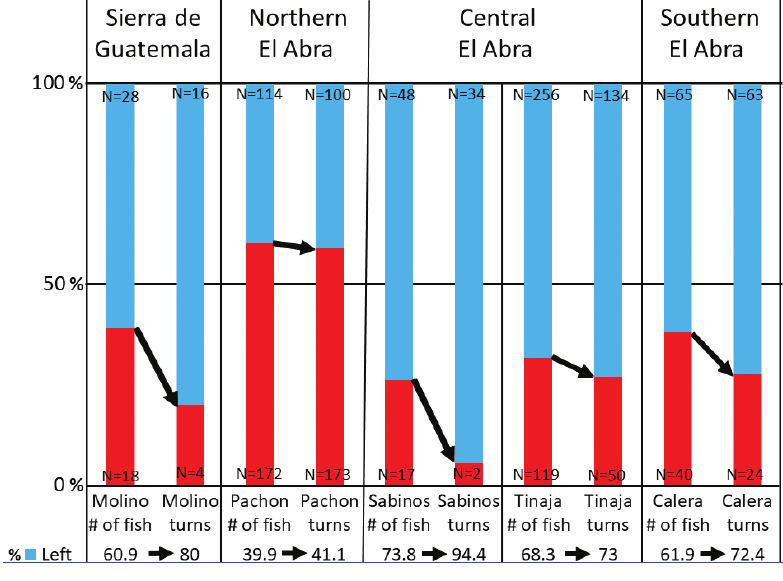
Figure 4. Highly responsive fish tend to proportionally use their left side more when compared to those individuals that display a less responsive behavior towards a vibrating stimulus. “# of fish” includes both individuals that only approach the device and then swim away and highly responsive fish that circle around the device. “Turns” counts the behavior exclusively of the highly responsive fish that circle the device. It would appear that highly motivated fish enhance their left-sidedness in their foraging behavior when responding with VAB, except perhaps in Pachón cave